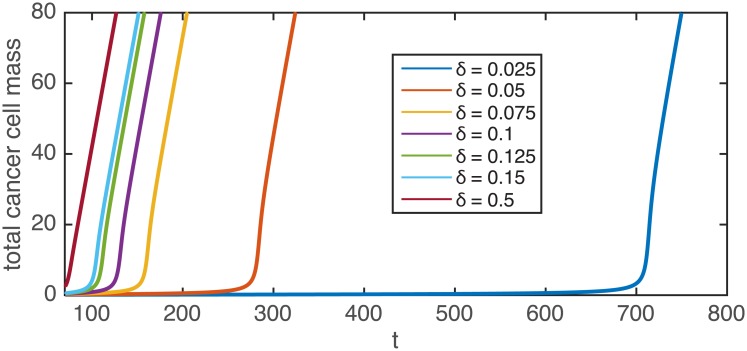
Total number of cancer cells as a function of time for different values of the resection threshold δ (ρ = 1, D = 1, K = 1, β = 0).A rough estimate of the time unit based on the experimentally observed in vitro proliferations rates is about 2–3 days. Note, that the case β = 0, shown in these simulations, gives an upper limit of the delay time, for nonzero β the values can be significantly lower.